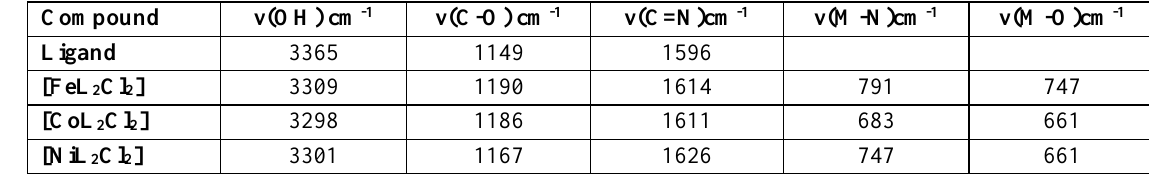
Table 4. The infrared spectral data of Schiff base and its metal (II) complexes. Compound